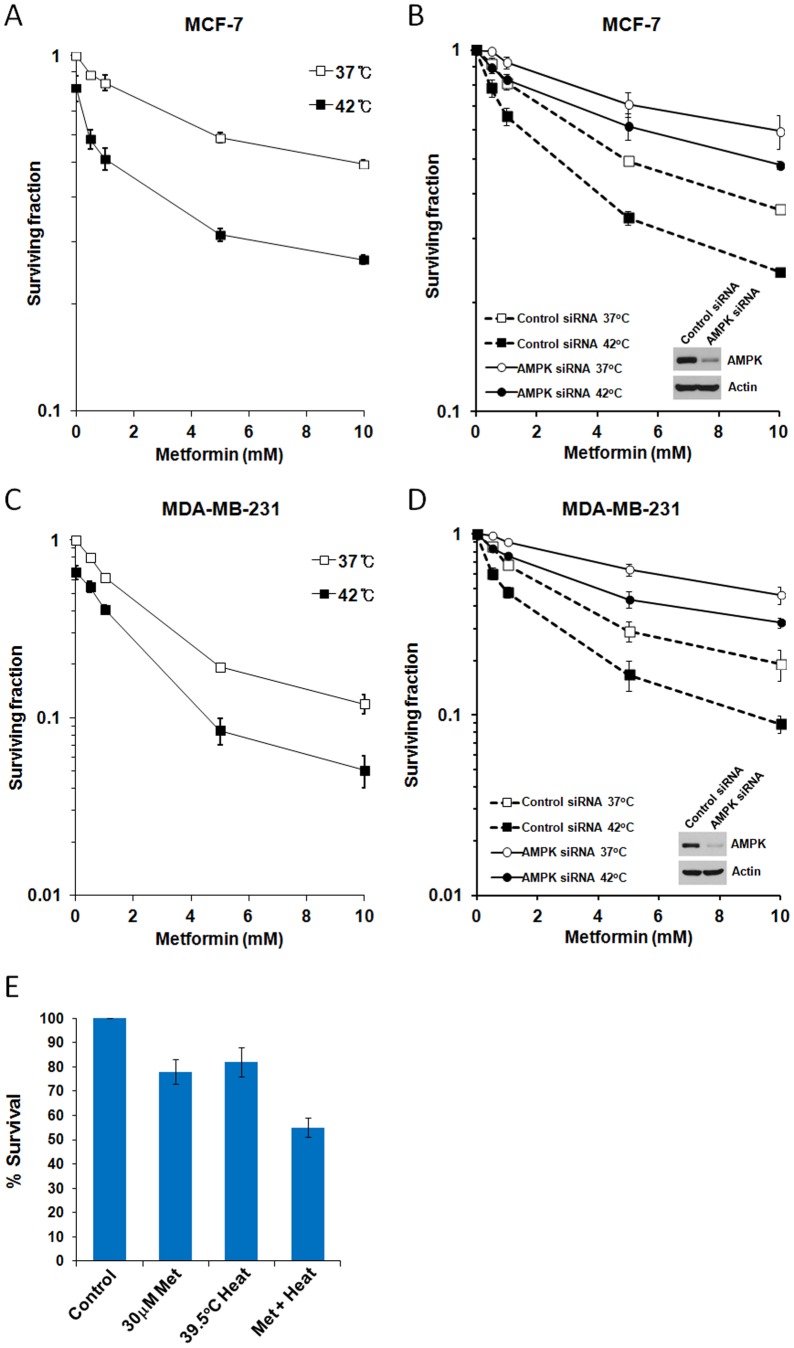
Clonogenic surviving fraction of MCF-7 and MDA-MB-231 cells after treated with hyperthermia and metformin.(A, C) Cells were incubated with 0–10 mM of metformin for 48 h at 37°C, or cells were heated at 42°C for 1 h with 0–10 mM metformin or without metformin and then incubated for 47 h at 37°C. After the 48 h metformin treatments, cells were washed and cultured for 18 days in regular media and the colonies formed were counted. Means of 6 experiments ±1 S.E. are shown. The decrease in cell survival by heating alone was statistically significant, and the survival of cells treated with the combination of heating and metformin was statistically smaller than that by metformin alone at all the metformin concentrations tested. (B, D) To elucidate the role of AMPK in the cell death caused by metformin alone or in combination with heating, cells were transfected with AMPK siRNA or control siRNA. The insets are Western blots for AMPK after transfection with control siRNA or AMPK siRNA. The transfected cells were treated with metfomin alone, heat alone or in combination with heating as described above and their clonogenic survival was determined. Cell death caused by the combined treatment was normalized for the death caused by heating alone. Means of 5 experiments ±1 S.E. are shown. The decreases in the effect of metformin by siRNA transfection were statistically significant both at 37°C and 42°C. (E) MCF-7 cells in medium containing 30 µM metformin were heated at 39.5°C for 6 h and then cultured at 37°C for 18 days. The effects of heating alone, metformin alone and combined on % survival of cells are shown. Means of 7 experiments ±1 S.E. are shown. The survival of cells treated with metformin in combination with heating was statistically smaller than that caused by metformin alone and heating alone.